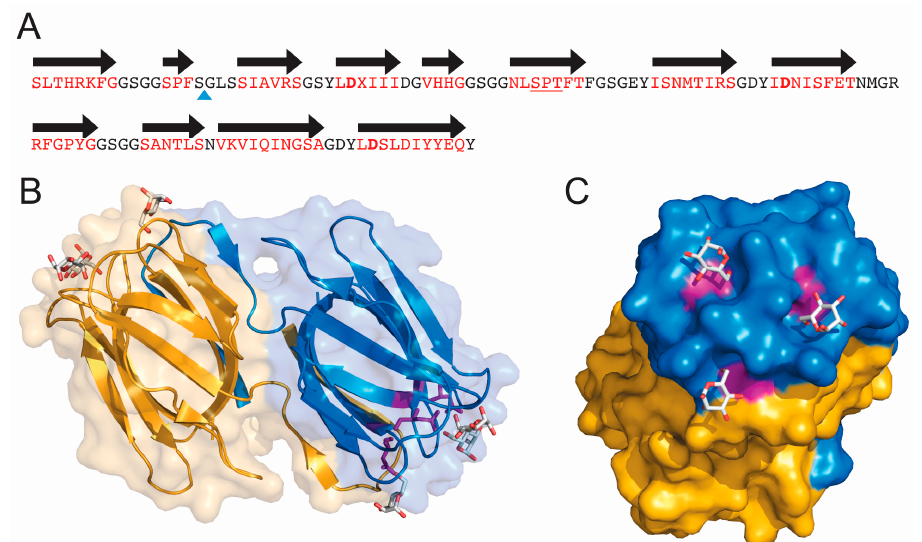
Figure 1. Sequence and three-dimensional structure of griffithsin (GRFT). ( A ) Sequence of wild-type GRFT. Amino acids located within beta strands are colored red and the black arrows correspond to secondary structure. X represents an unknown amino acid of mass 151.05 present in the natural alga-derived material. The blue triangle shows the site of the Gly-Ser insertion used to produce the monomeric version of GRFT (mGRFT). The three Asp residues located in the three mannose-binding sites are shown in bold; ( B ) Ribbon drawing showing the three-dimensional structure of GRFT. Each monomer of the domain swapped dimer is colored yellow or blue. Mannose residues bound to the carbohydrate binding sites are shown in stick representation. Aspartic acids present in the binding sites are colored purple; ( C ) Rotated view of GRFT showing the carbohydrate binding face and mannose binding sites. ( B , C ) were generated using the program Pymol (Delano Scientific LLC, Palo Alto, CA, USA) and protein data bank accession number 2GUD.